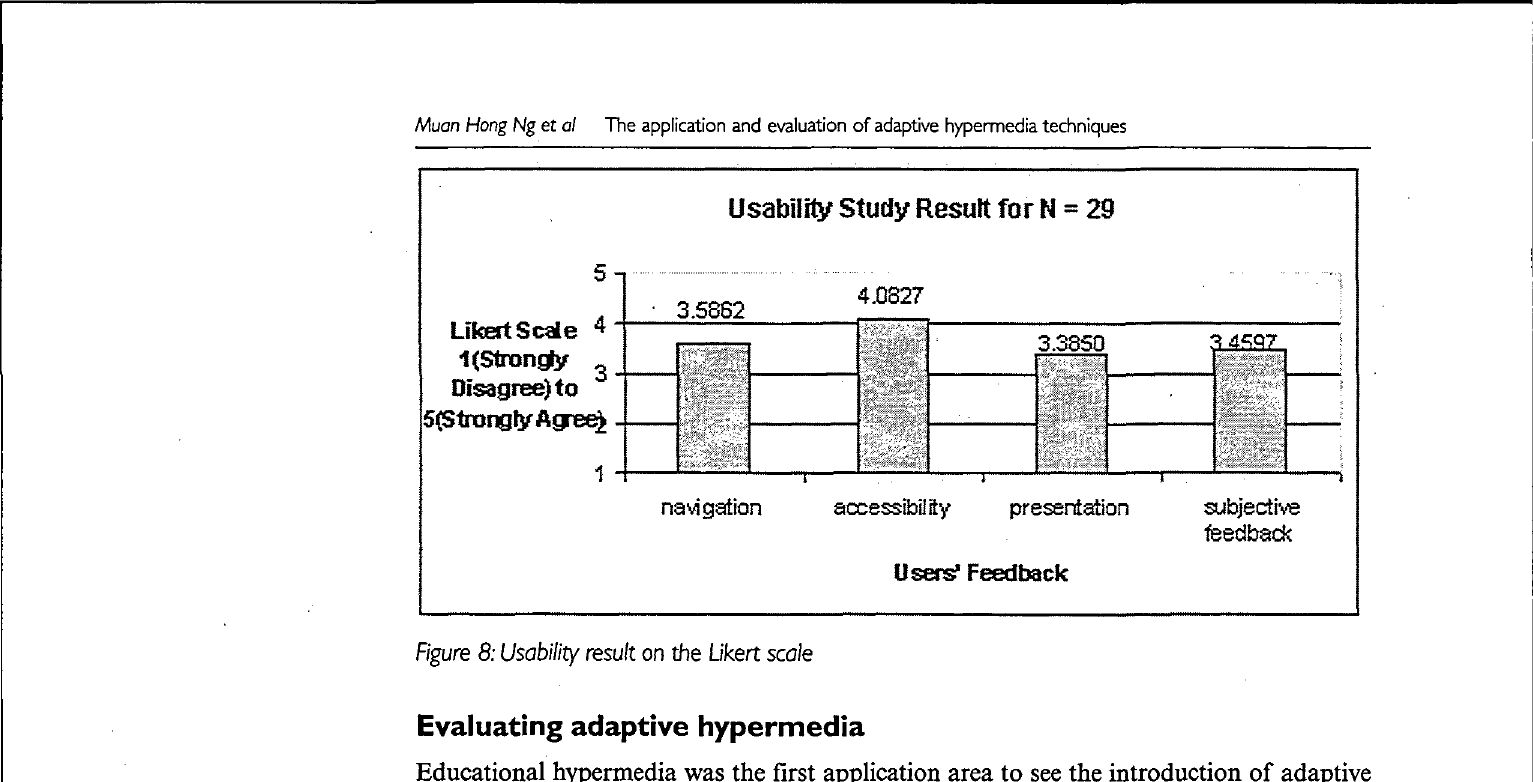
Figure 8: Usability result on the L/kert scale Evaluating adaptive